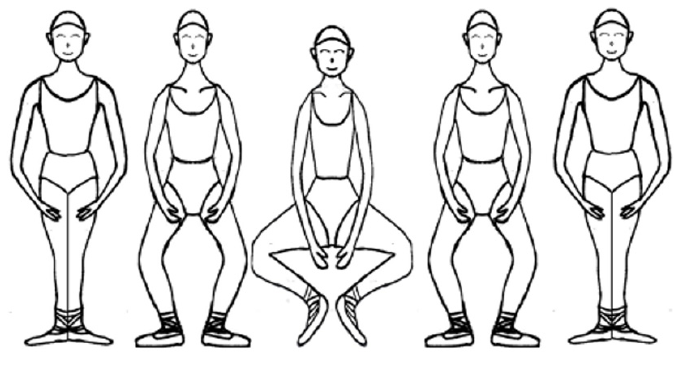
Figure 2. Grand-plie. Figure 2. Grand ‐ plie. Figure 2. Grand ‐ plie.